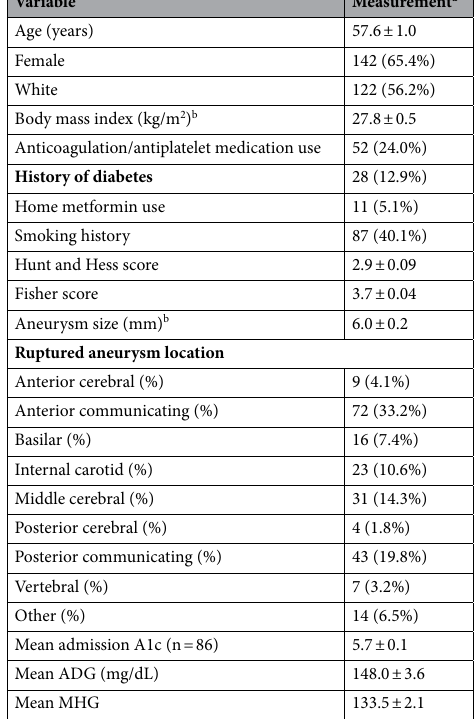
Table 1. Baseline patient characteristics (n = 217). a Measurement is reported as mean ± SEM or count (%). b Non-normally